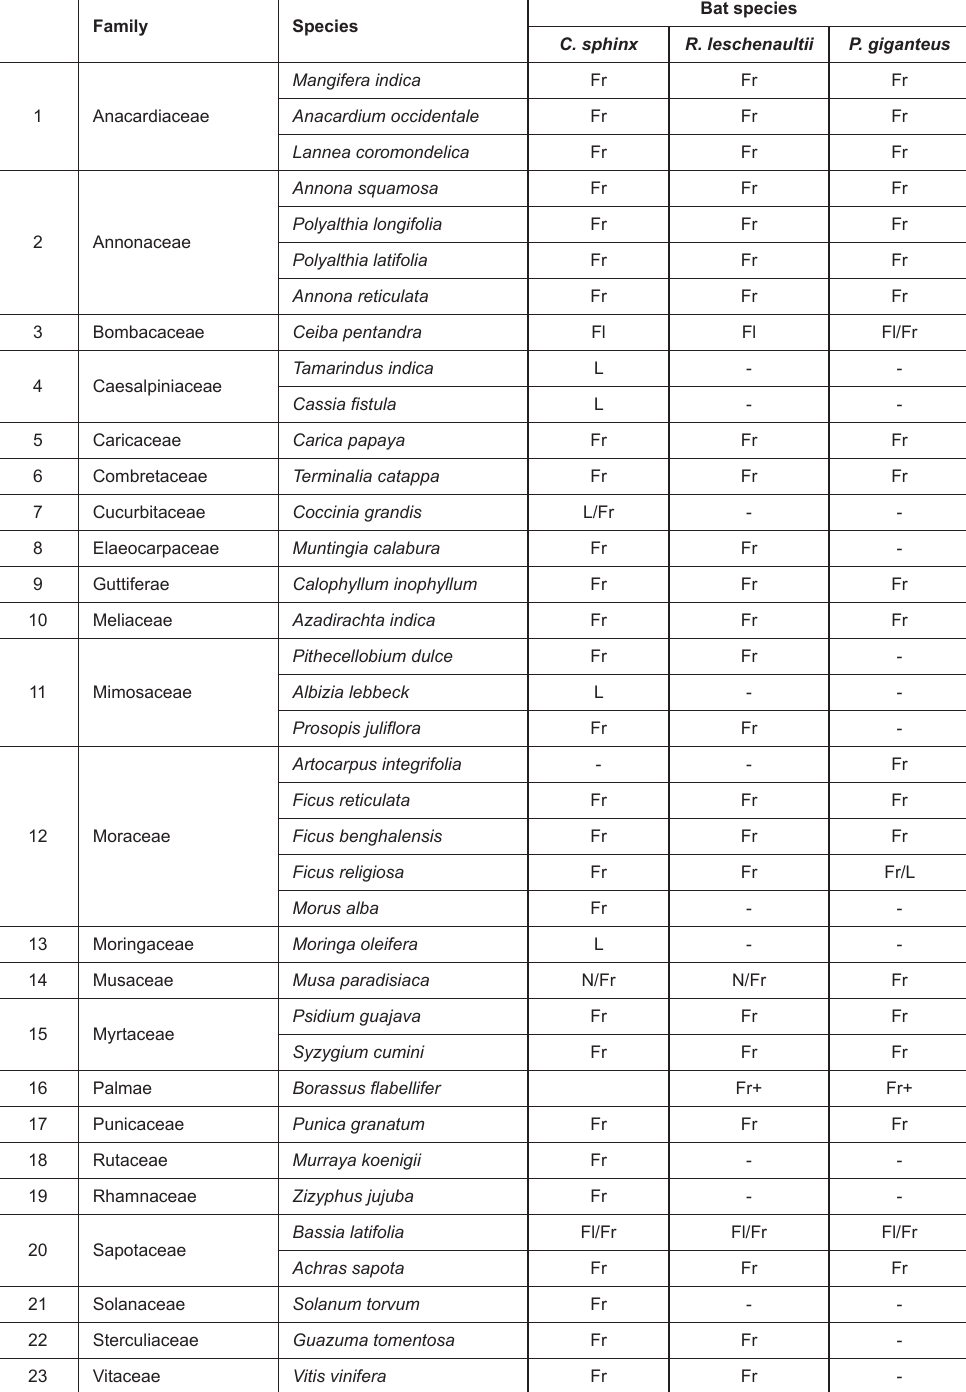
Table 1. Food providing plants for pteropodid bats and parts eaten by them